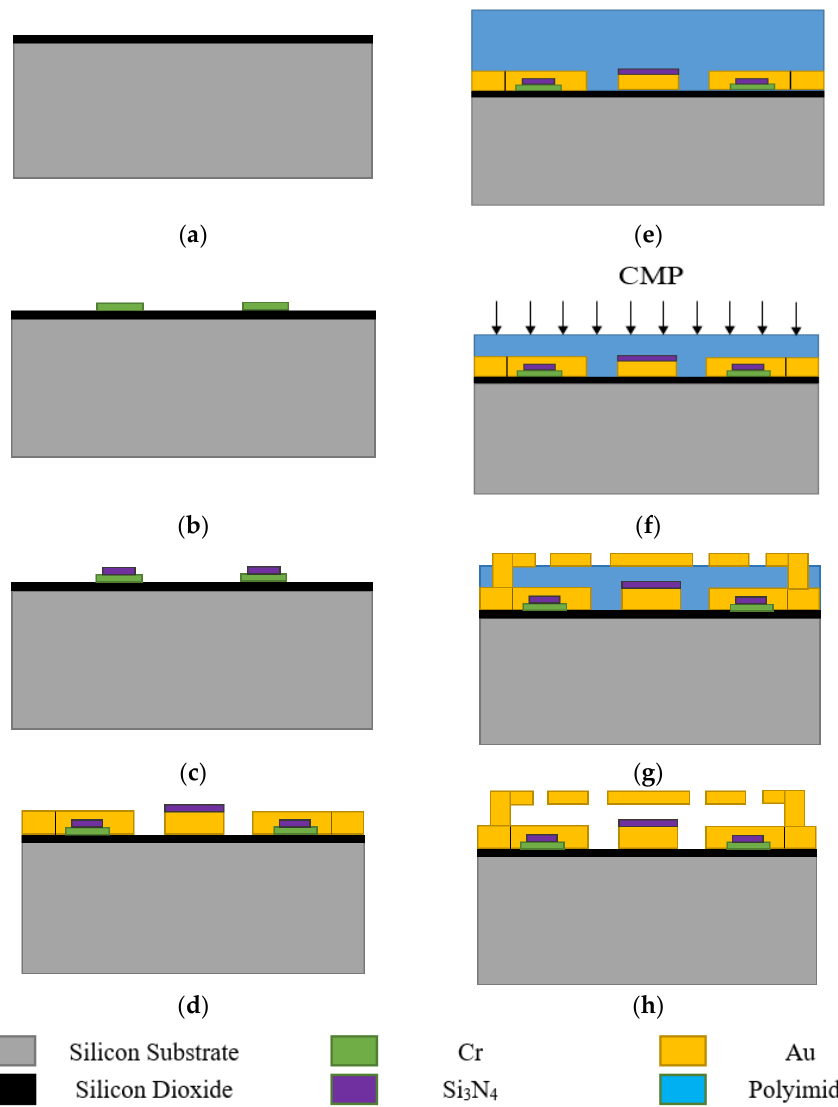
Figure 7. The process of the device: ( a ) silicon substrate after oxidation; ( b ) after patterning of the high-resistance direct current (DC)-bias line; ( c ) after patterning of the Si 3 N 4 dielectric layer; ( d ) after patterning of coplanar waveguide (CPW) lines; ( e ) spinning of polyimide to form sacrificial layer; ( f ) Chemical mechanical polishing (CMP) to decrease surface roughness of polyimide; ( g ) patterning of gold layer to form MEMS beams and anchors; ( h ) removal of the sacrificial layer.